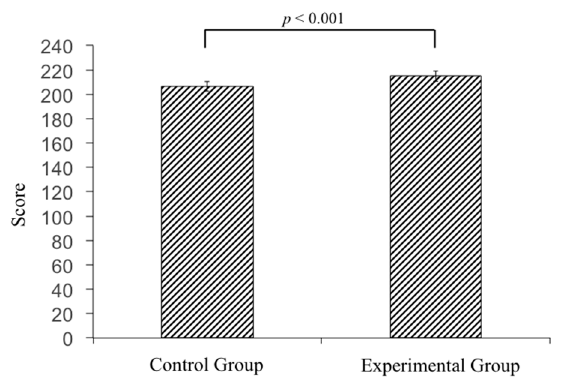
Figure 4. The average mock OSCE scores of the control group showed a significant difference when comparing the third exam to the first one ( p = 0.001), whereas in the experimental group, there was already a significant improvement found between the second and first, and the third and the first mock OSCE scores ( p < 0.001).